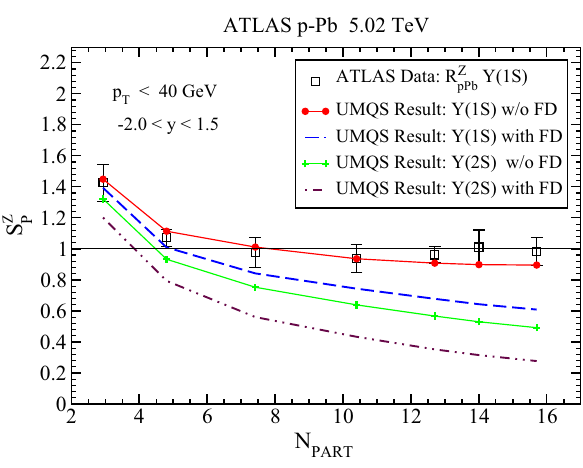
Fig. 17 The centrality variation of p T integrated survival probability ( 1 S ) ) for with and with out feed of ϒ( 1 S ) to Z boson yield ratio ( S Z P downcorrectioniscomparedwiththemeasured ϒ( 1 S ) to Z bosonyield ratio ( R Z ) versus centrality in p–Pb collisions from ATLAS exper- √ pPb s NN = 5 . 02 TeV [92]. Prediction for centrality variation iment at of p T integrated survival probability of ϒ( 2 S ) to Z boson yield ratio √ ( 2 S ) ) in p–Pb collision at s NN = 5 . 02 TeV is also plotted for ( S Z P